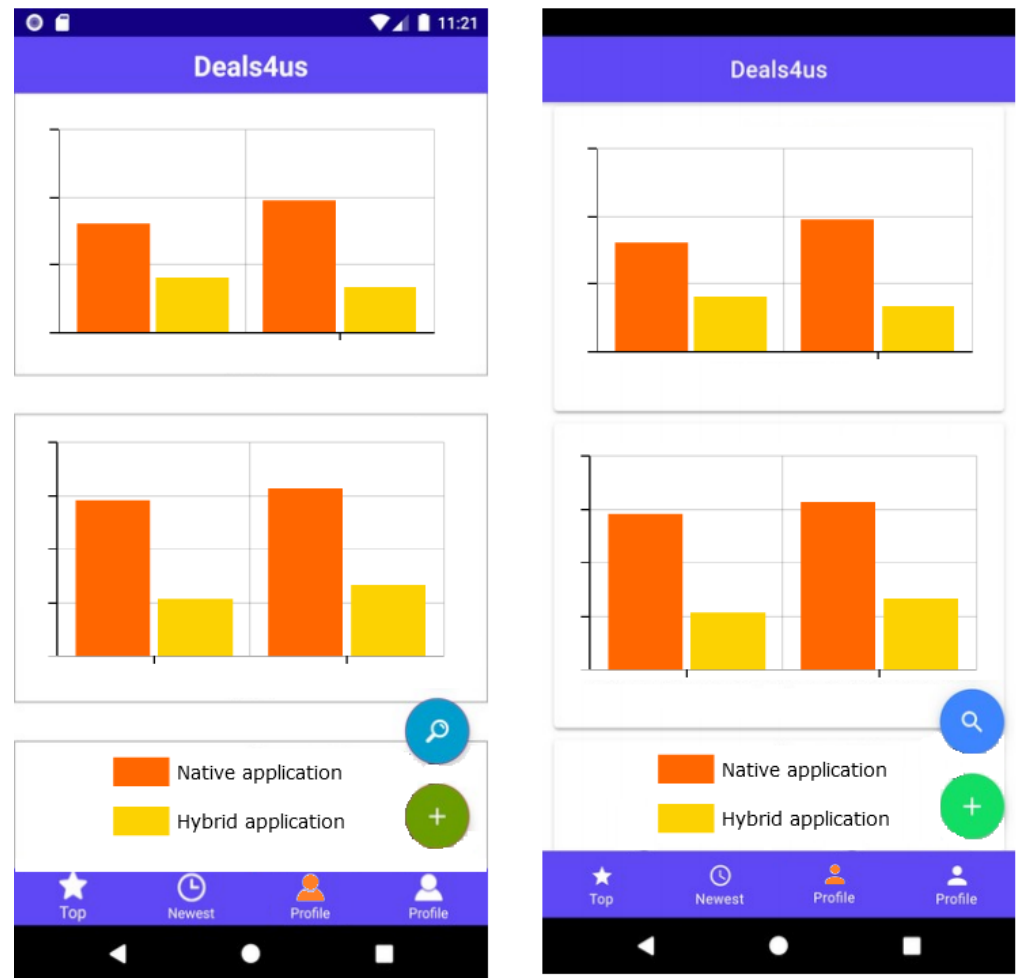
Figure 6. User interface (list with deals) in ( left side ) the native application and ( right side ) the hybrid application.